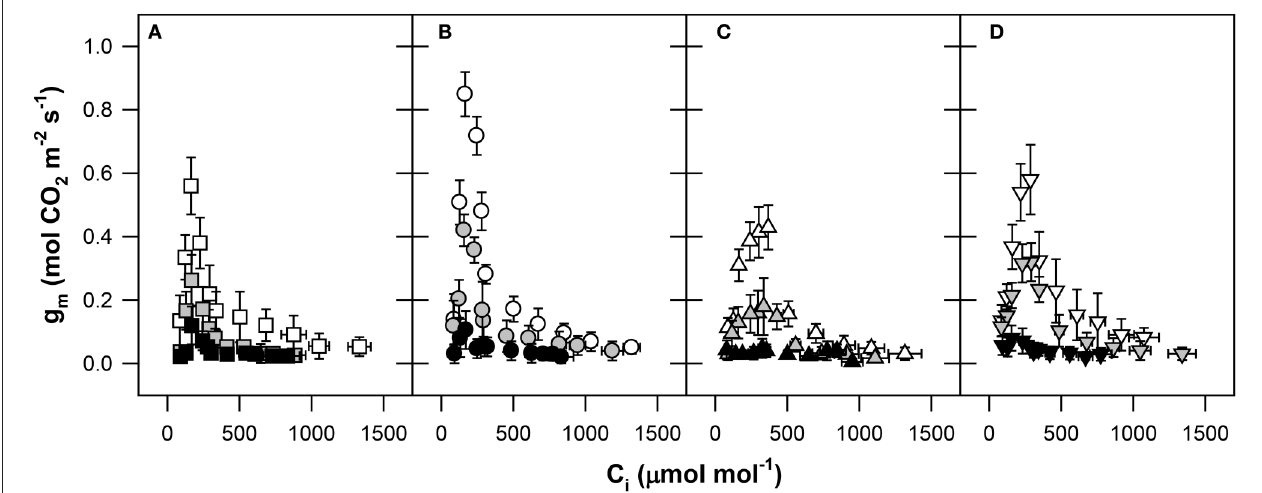
FIGURE 5 | The response of mesophyll conductance (g m , mol CO 2 m − 2 s − 1 ) to rapid changes in the CO 2 concentration within intercellular spaces (C